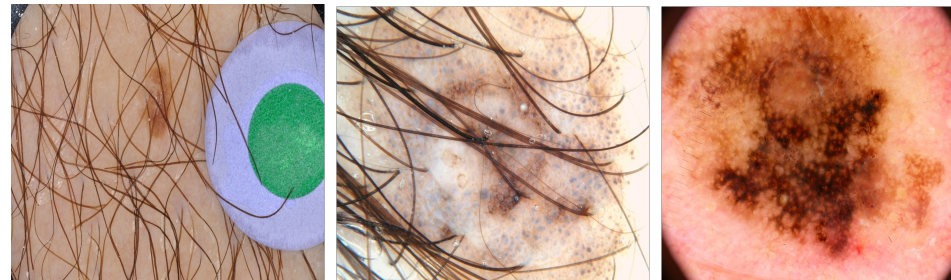
Figure 1. Some skin lesion images with